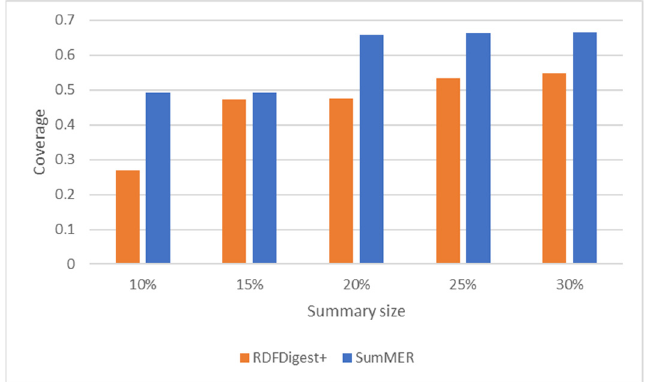
Figure 7. Coverage for testing on DBpedia v3.8 .